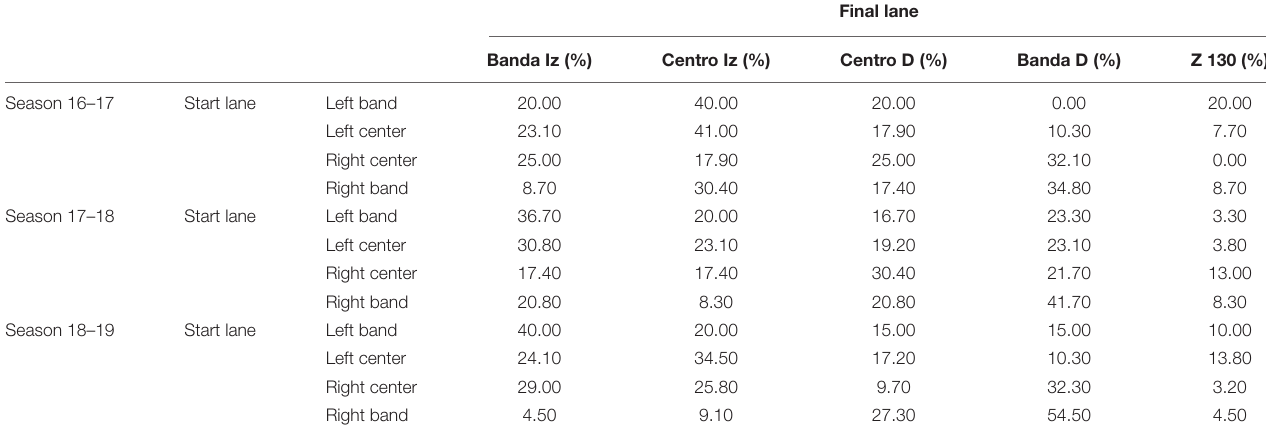
TABLE 5 | Contingency table: Season * Start Lane * Final Lane.